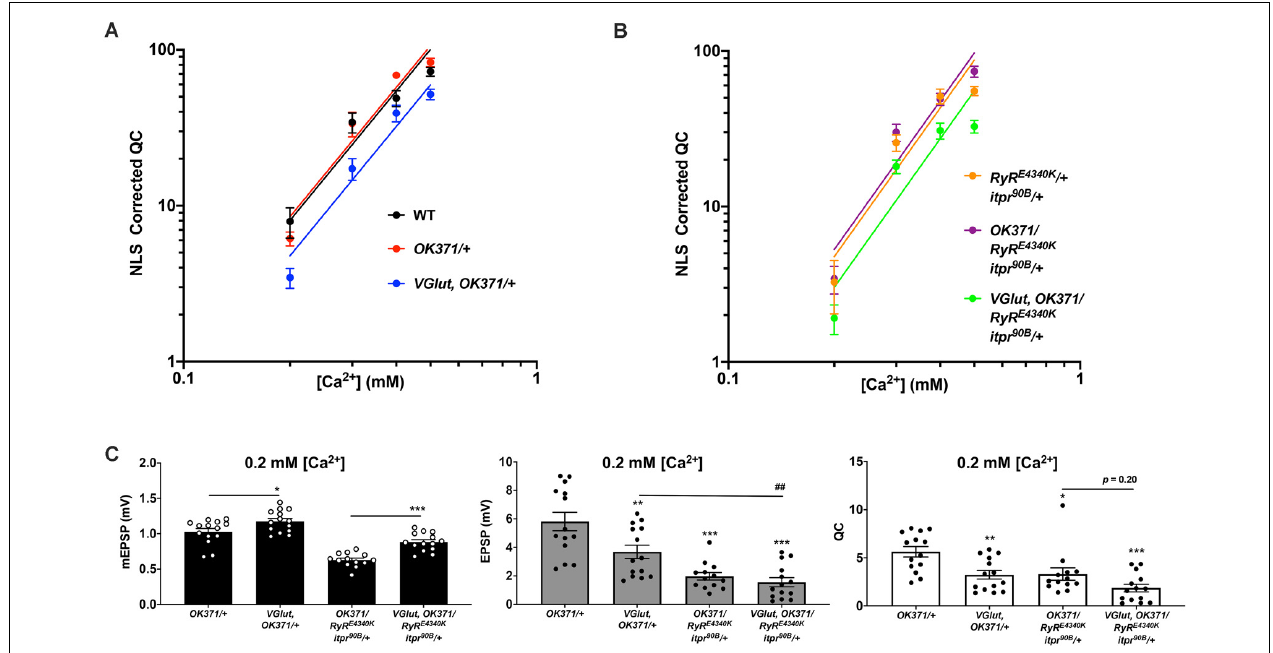
FIGURE 7 | Ca 2+ concentration-sensitivity of PHD execution. (A) log-log plots of recording saline [Ca 2+ ] vs. QC corrected for non-linear summation for WT, OK371/+ , and VGlut, OK371/+ conditions. Across the range of [Ca 2+ ] examined, there is no significant difference in calcium cooperativity for these conditions (Nonlinear Regression, p = 0.91 ). (B) Data plotted as in (A) but this time with a double heterozygous RyR E4340K /+; itpr 90B /+ genetic background. Across the range of [Ca 2+ ] examined, there is no significant difference in calcium cooperativity for these conditions (Nonlinear Regression, p = 0.78 ). (C) Raw data for mEPSPs (left); raw data for EPSPs (middle); raw data for QC (right). All data are for the indicated NMJ genotypes in 0.2 mM [Ca 2+ ]; bars are averages and error bars are ± SEM. For mEPSPs, * p < 0.05 and *** p < 0.001 by Student’s t -test, comparing PHD-challenged genotypes vs. unchallenged genetic controls. For EPSPs and QC, * p < 0.05, ** p < 0.01, and *** p < 0.001 vs. OK371/+ ; ## p < 0.01; EPSP and QC analyses done across multiple genotypes by one-way ANOVA with Tukey’s post-hoc